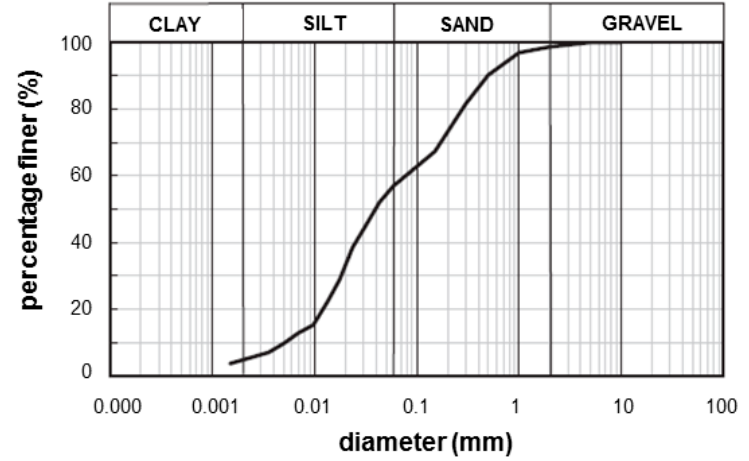
Figure 3. Grain size distribution of soils constituting pyroclastic soil cover.